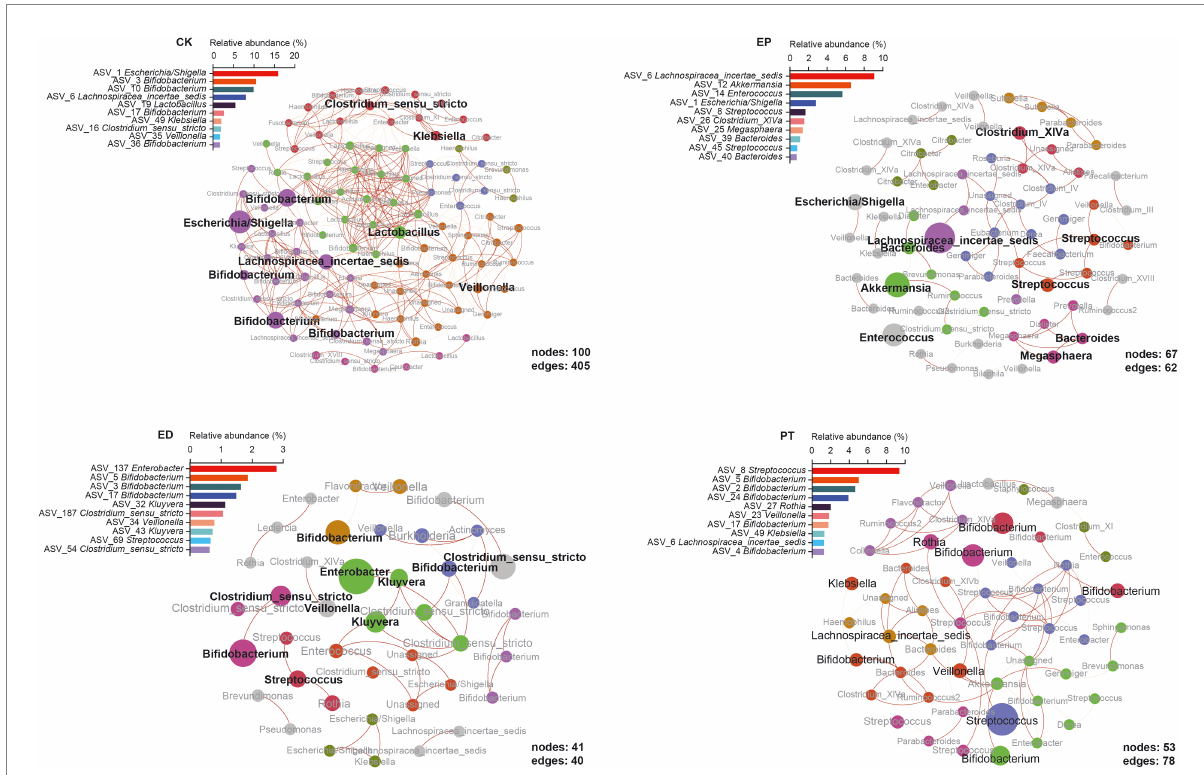
FIGURE 4 Epilepsy (EP) and concomitant diarrhea (ED) attenuated the network interactions of the gut bacterial taxa, and special microbiota occupied the keystone interaction nodes in microbiome